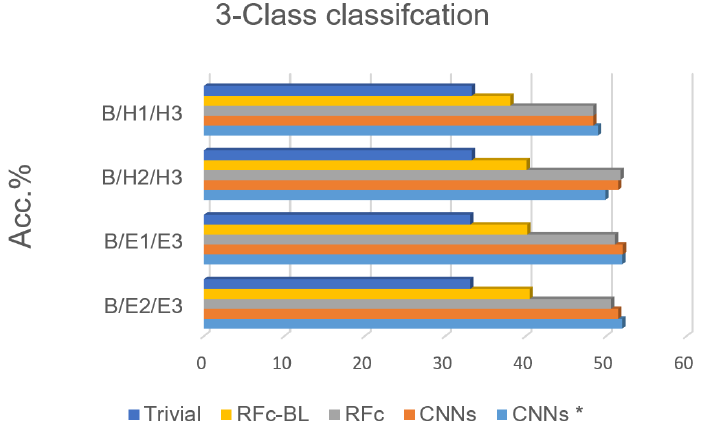
Figure 8. Recognition models for 3-class classification tasks compared to trivial and baseline